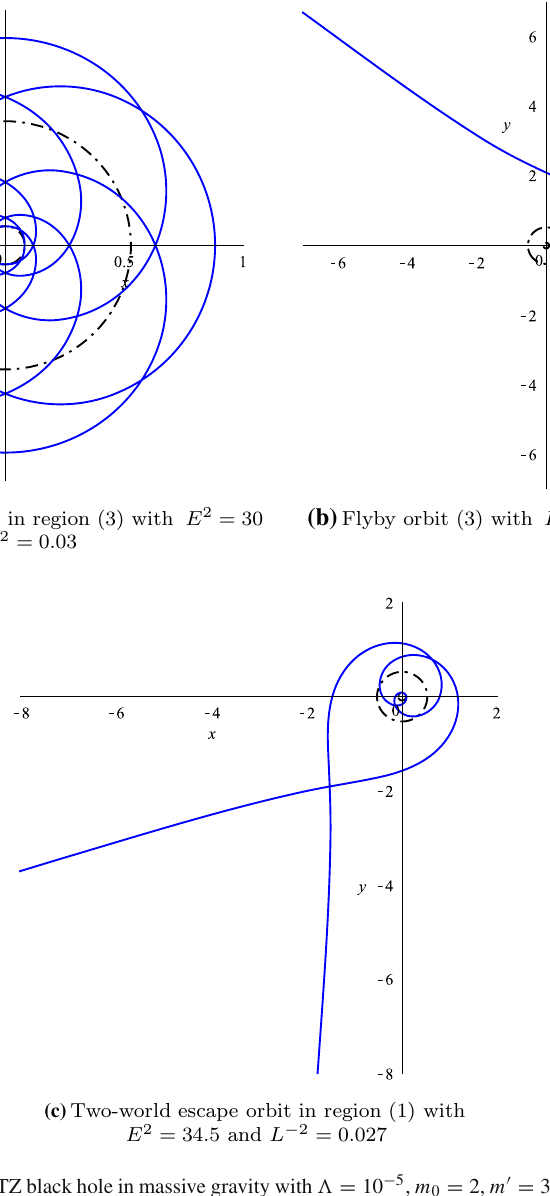
Fig. 15 Null geodesics in the charged BTZ black hole in massive gravity with (cid:4) = 10 − 5 , m 0 = 2, m (cid:5) = 3 . 02, q = 0 . 6 and r 0 = 0 . 93. The dashed dot lines represent